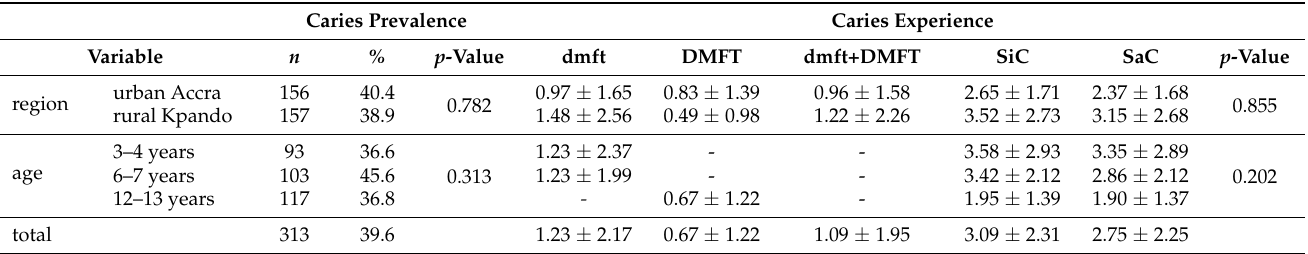
Table 2. Outcomes in caries prevalence and experience (mean dmft+DMFT, SiC, and SaC) dependent on region and age.